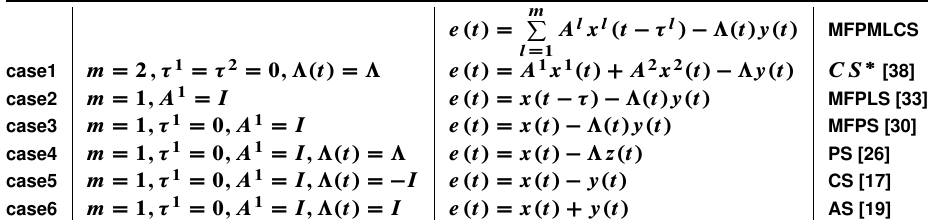
Table 1. The special cases of